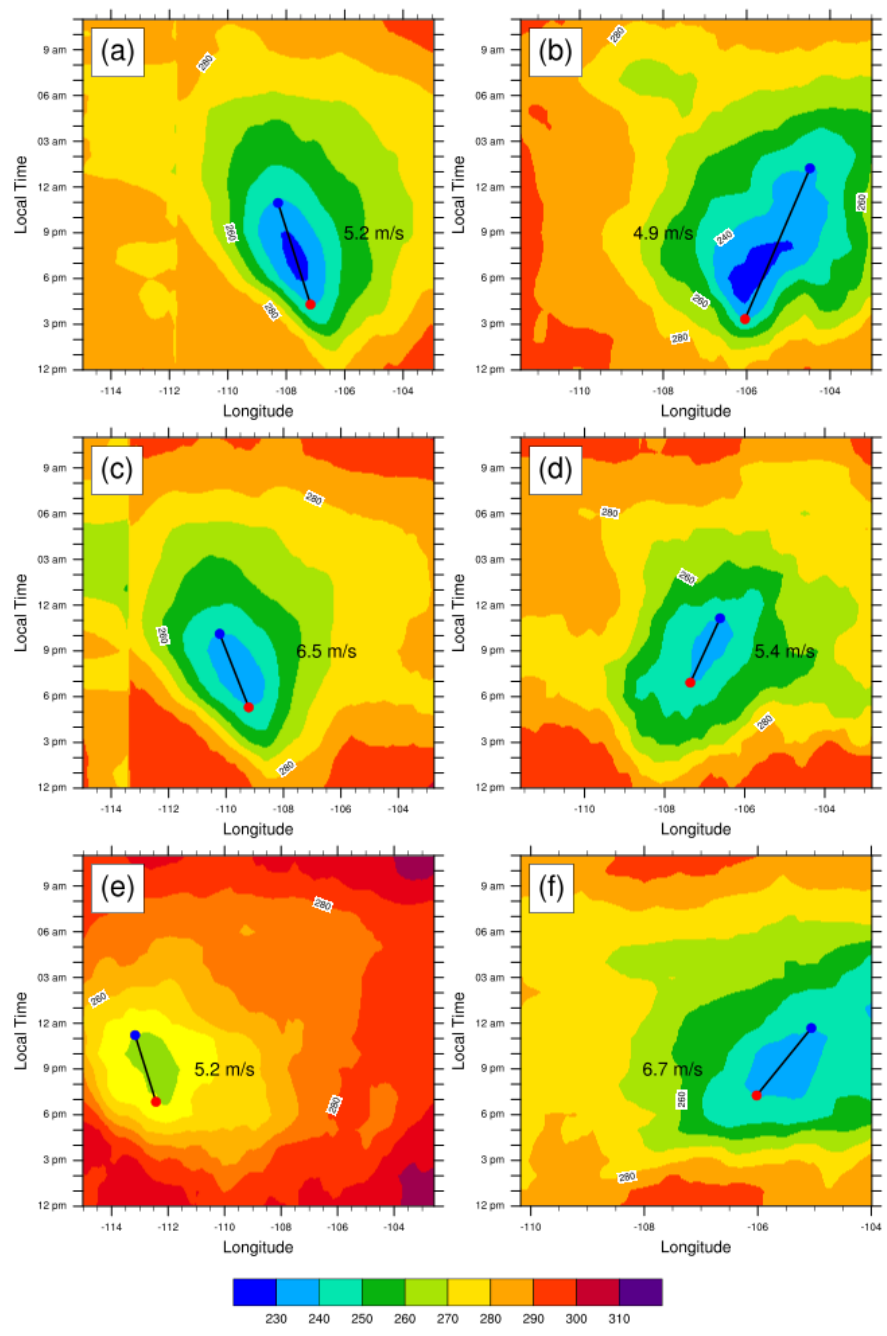
Figure 10. Hovmöller diagram of BT composite of MCS events for trajectory 1 ( a , c , e ) and 3 ( b , d , f ). Upper, middle and lower panels correspond to the Band A, B, and C, respectively. Red (blue) point corresponds to MCS initiation (dissipation). The color bar represents BT values in Degrees K. The black line is used to estimate the speed of propagation (see text for